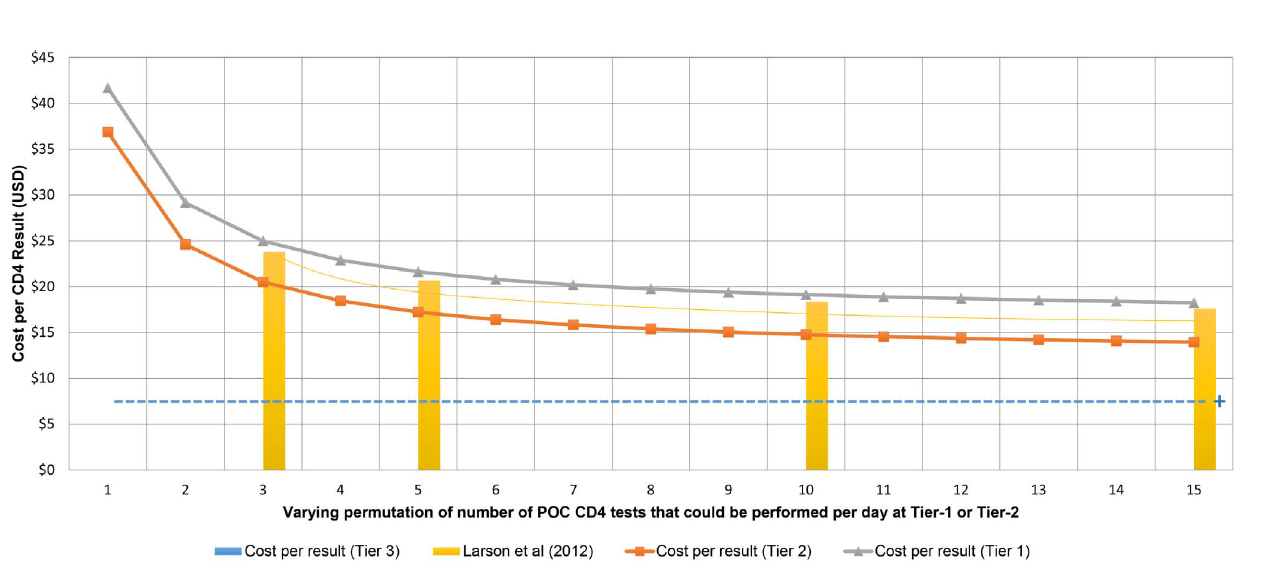
Fig. 4. Costs per samples tested. Cost-per-result based on number of samples run per day for Tiers 1 and 2 (line graphs), compared to published POC data [14] (actual reported points as light yellow bar graphs with extrapolated curve) versus baseline cost-per-result for Tier-3 (pale blue dotted line). The ‘ + ’ at the end of line represents higher capacity of workload of Tier-3